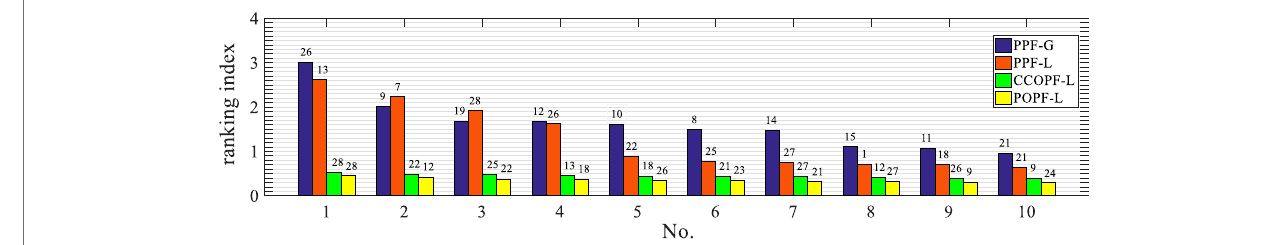
FIGURE 11 | Contingency ranking of top ten according to different methods.